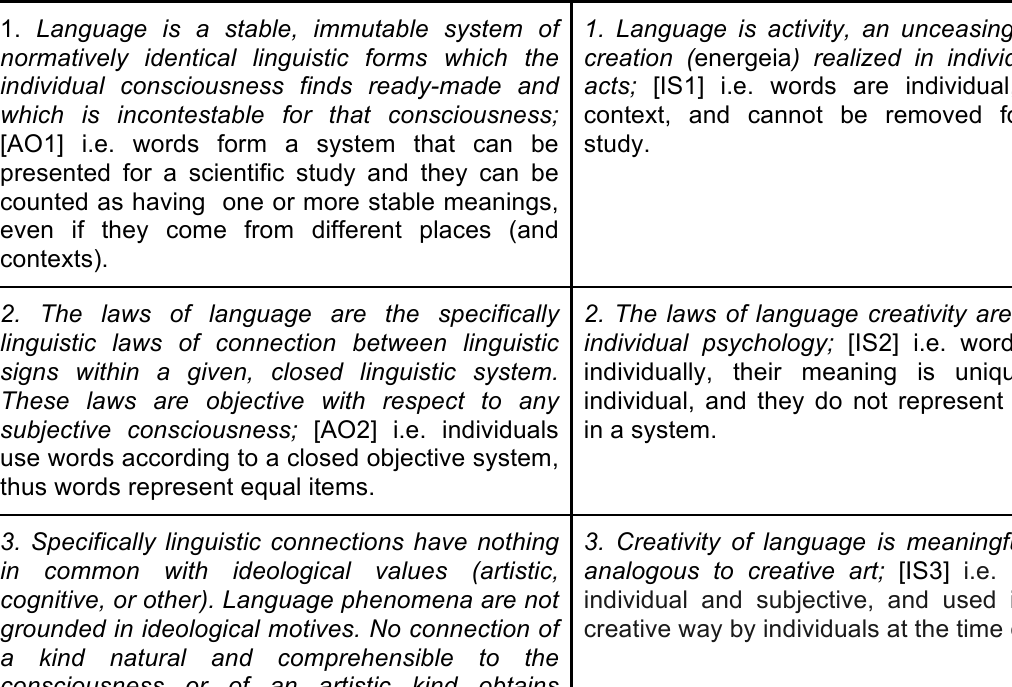
Table 1. Abstract objectivist and individual subjectivist approaches to